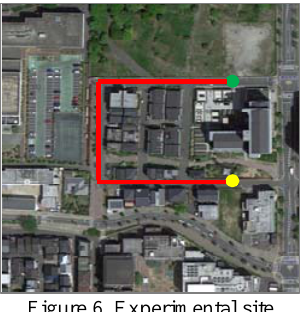
Figure 6. Experimental site